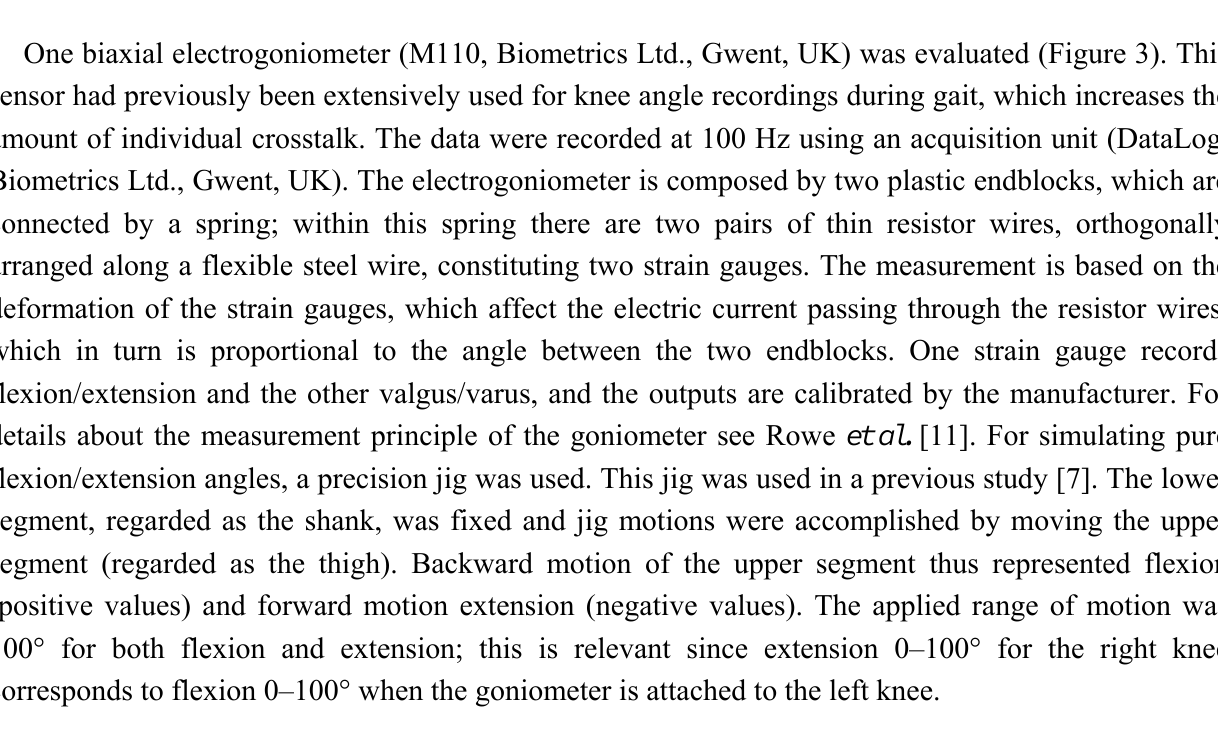
Figure 3. The biaxial goniometer (Biometrics Ltd., Gwent, UK; blue model [XM110]), used for knee